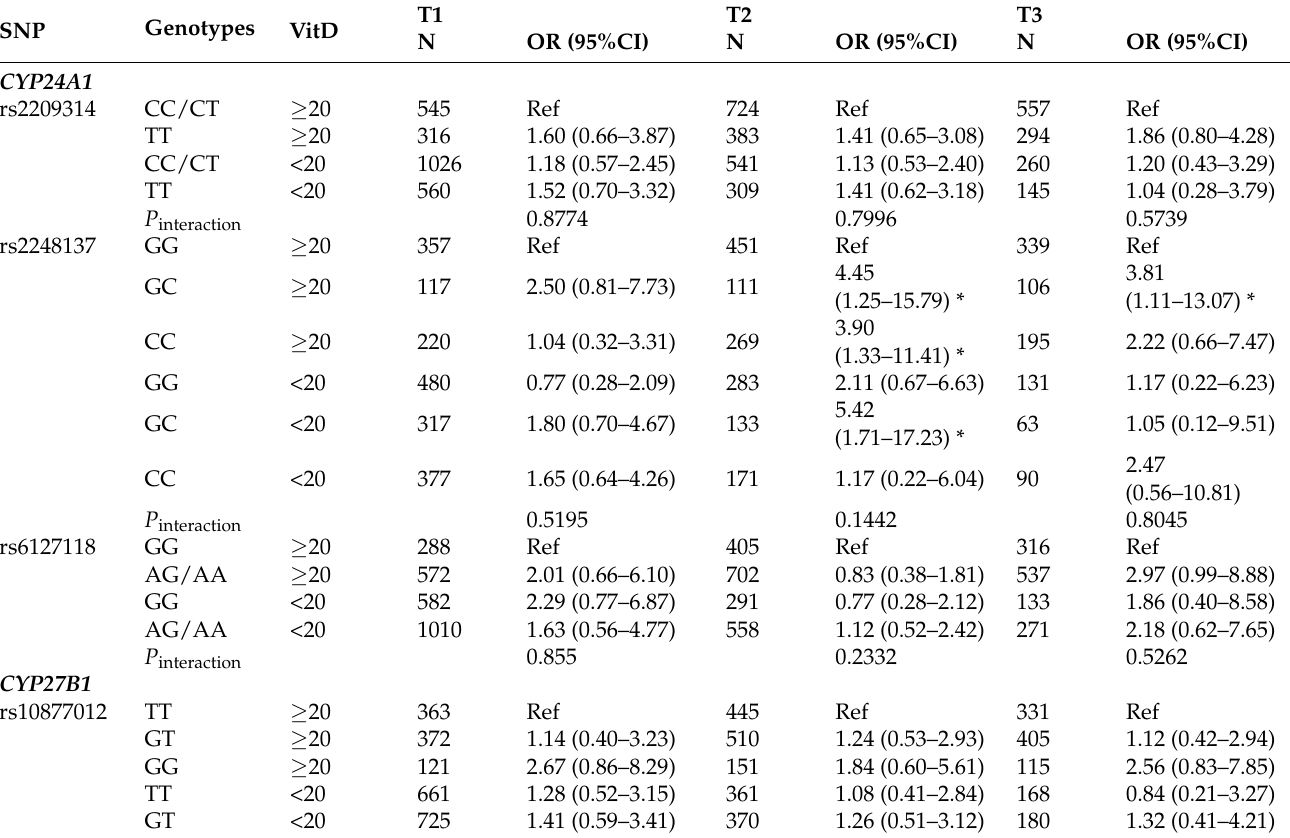
Table 6. The interaction between SNPs and VitD in three trimesters on the risk of